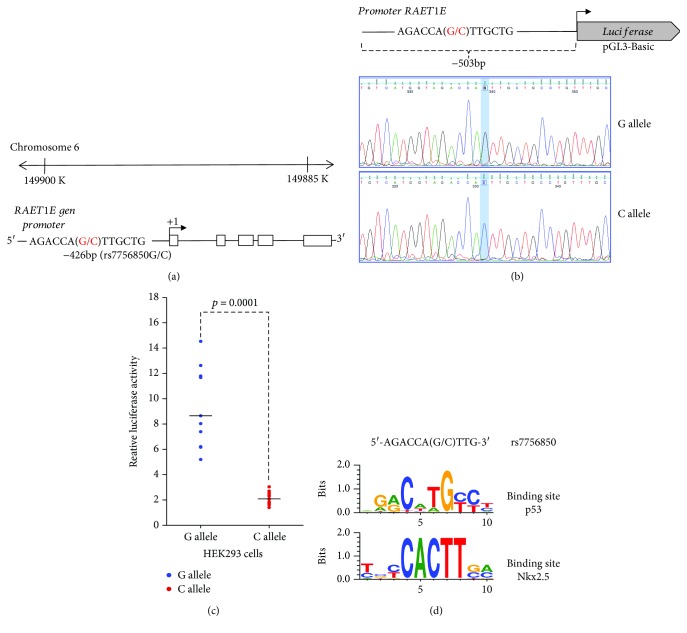
rs7756850 affects transcriptional activity of raet1e promoter sequence. (a) Schematic diagram of the raet1e gene and location of allelic variants on promoter sequence (−426 bp, G/C). (b) Construction of plasmid. The promoter sequence with each variant was cloned in the pGL3 vector into MluI/XhoI sites to direct the expression of the luciferase gene. Both constructions (G allele and C allele) were confirmed by sequencing. (c) Dual-luciferase assay in HEK293 cells. The presence of the C allele reduces the promoter activity of the cloned sequence (−503 bp) in ≈85% as compared with the promoter activity of the sequence harboring the G allele (p = 0.0001). Lines represent the median of four independent experiments performed in triplicate (n = 11). p < 0.05 was determined by the Mann-Whitney U test. (d) In silico analysis suggests that variant rs7756850 modifies the consensus site for p53 and Nkx2.5 transcription factors. Due to the raet1e gene orientation into chromosome 6, the G allele is considered the ancestral allele in the luciferase assays.